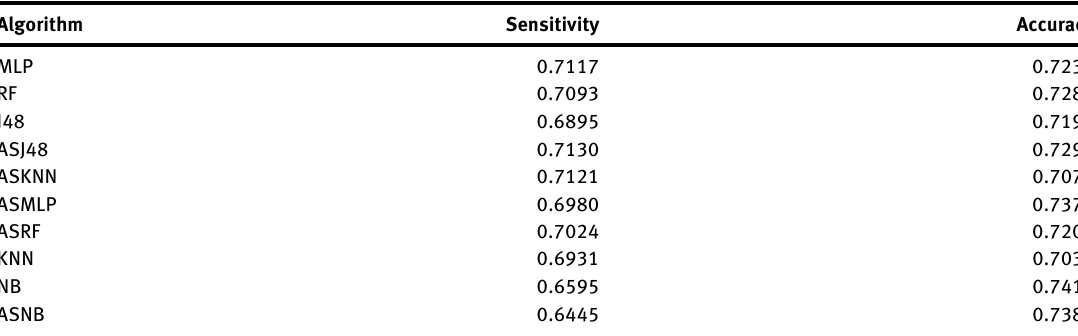
Table 5: Sensitivity and accuracy values obtained for testing